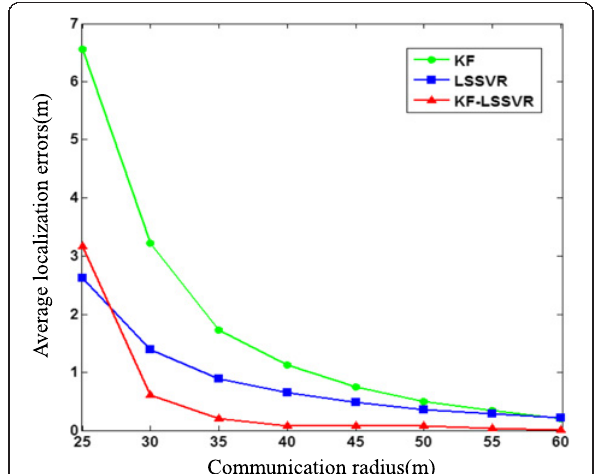
Fig. 4 Relationship between average localization errors and communication radius